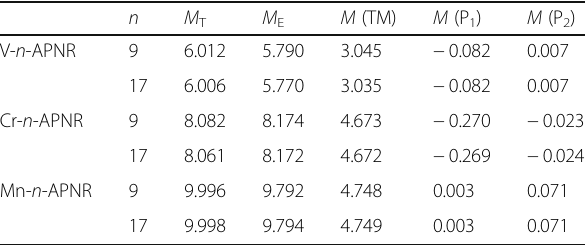
The total magnetic moments come mainly from the ≈ M ) and in unit of μ per primitive edge atoms ( M T E B cell are close to the valence electron numbers of the transition metal atoms minus 4. In V- n -APNRs, the edge P atoms (P and P ) are antiparallelly polarized slightly 1 4 while the second edge P atoms (P and P ) are parallelly 2 3 polarized. So the magnetic moments of the P atoms are almost canceled with each other. Each V atom has a Table 2 The total ( M T ), edge ( M E ), and single-atom magnetic moments in unit of μ B per primitive cell in TM- n -APNRs for n = 9 and